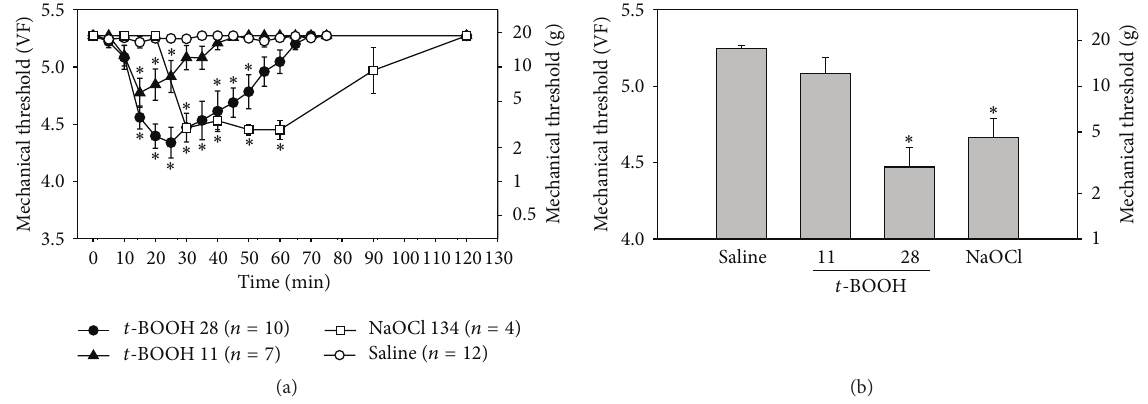
Figure 1: Effects of t -BOOH and NaOCl on mechanical thresholds in normal rats. (a) Intrathecal administration of t -BOOH (11 or 28 𝜇 mol) or NaOCl (134 𝜇 mol) temporarily decreased the mechanical threshold in a dose-dependent manner, compared to the mechanical threshold observed with administration of saline. Asterisks indicate values that are significantly different from those for the saline group as determined by a two-way repeated-measures analysis of variance with one repeated factor followed by the Duncan post hoctest ( 𝑃 < 0.05 ). (b)Mechanical thresholds of hind paws after intrathecal administration of t -BOOH (11 𝜇 mol, 𝑛 = 7 ; 28 𝜇 mol, 𝑛 = 10 ) or NaOCl (134 𝜇 mol, 𝑛 = 4 ), compared with the mechanical threshold observed with saline, 30 min after injection. Asterisks indicate values that are significantly different from that for the saline group as determined by the Kruskal-Wallis analysis of variance by ranks followed by the Dunn test ( 𝑃 < 0.05 ). The data are mean with standard errors of the mean. VF, von Frey filament